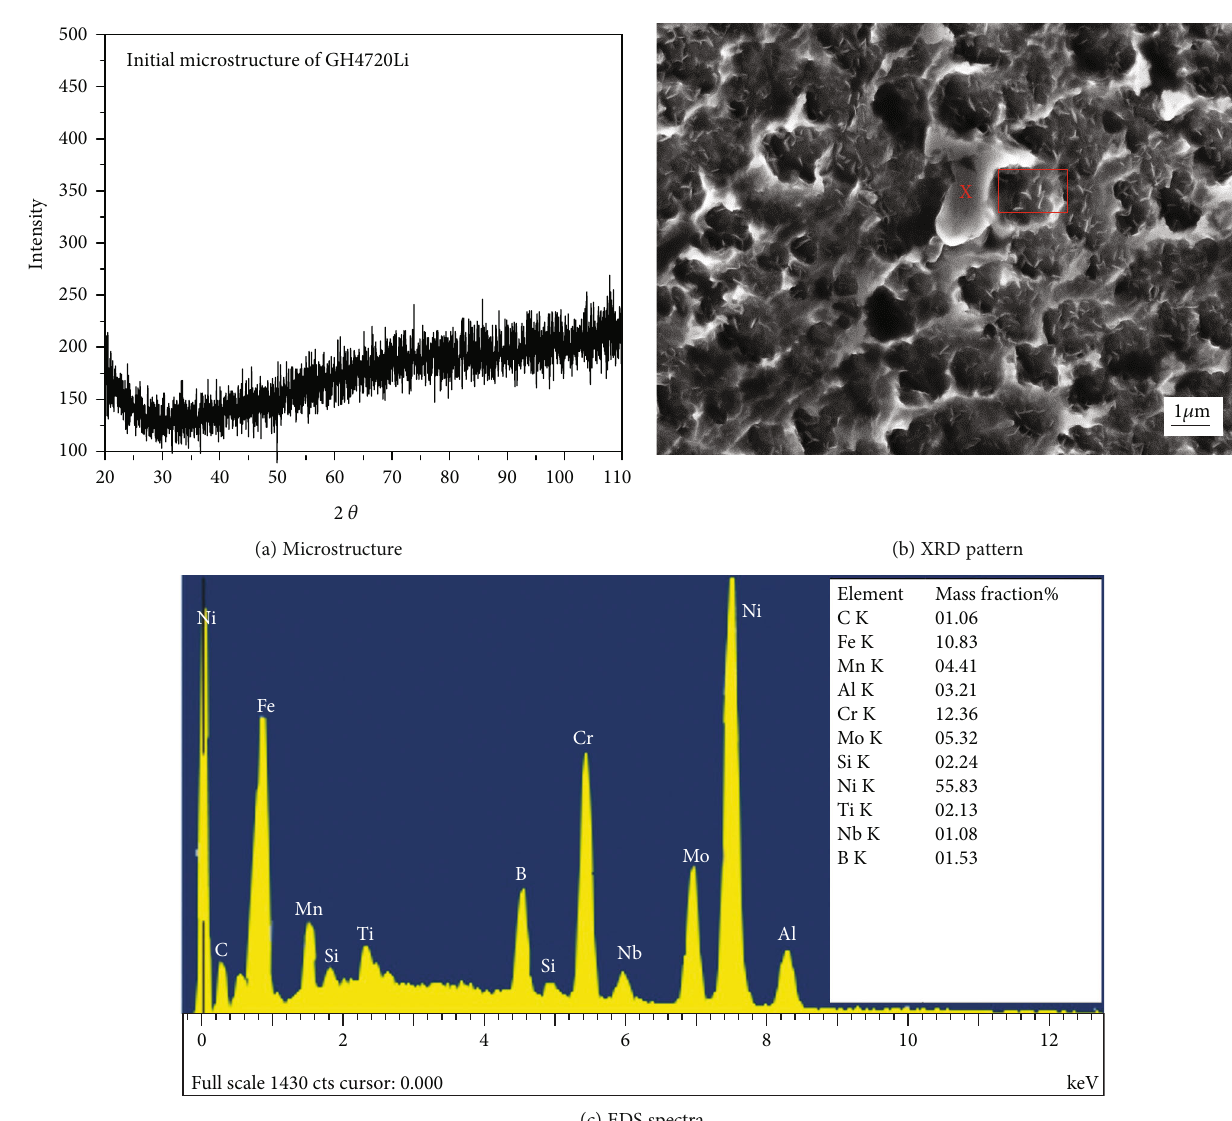
Figure 3: The microstructure and XRD pattern and EDS spectra of GH4720Li